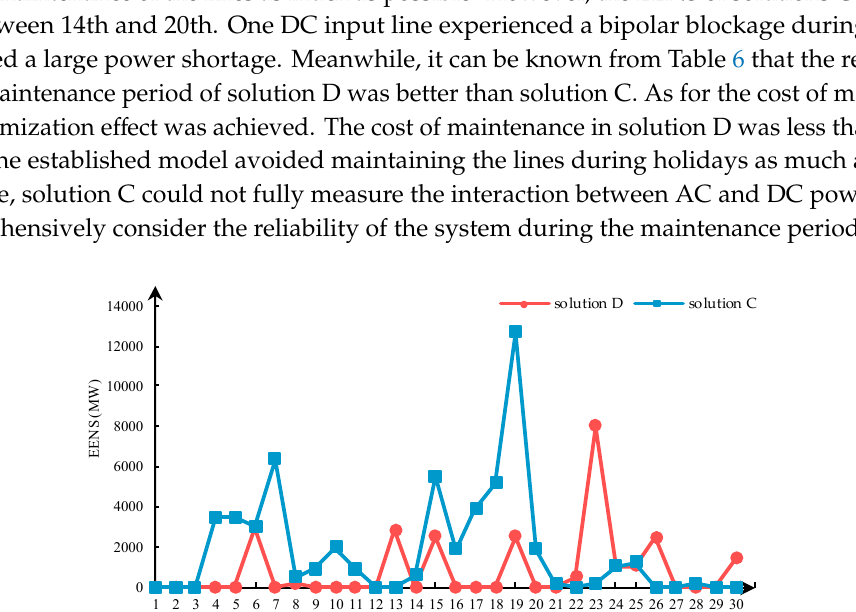
Figure 11. Transformer maintenance scheduling and resource arrangement.